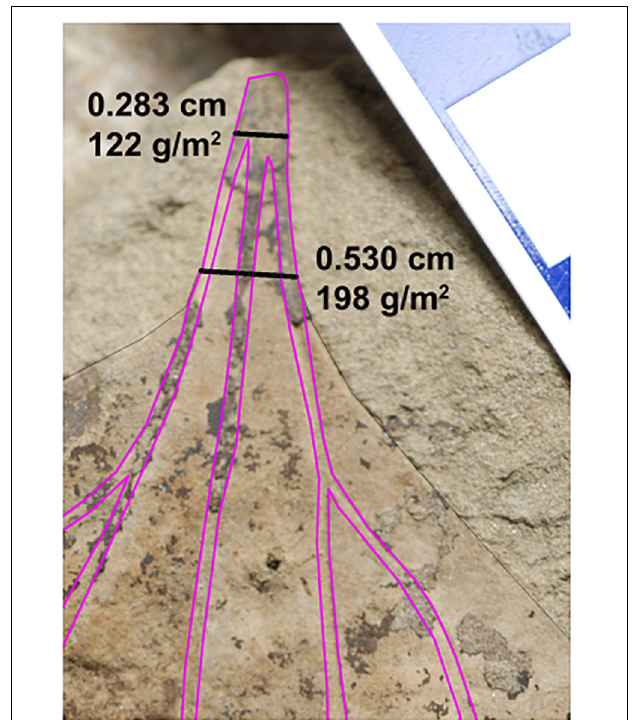
FIGURE 3 | Representative revision from the Williston Basin. The two black lines are the revised petiole width measurement used in this study (top) and original measurement of Blonder et al. (2014) (bottom). Primary and secondary veins are traced with magenta lines. For each number pair, the top number is the petiole width and bottom is the estimated leaf dry mass per area. Morphotype HC162, Marmarthia pearsonii, DMNH 21687. Scale bar = 1 cm.